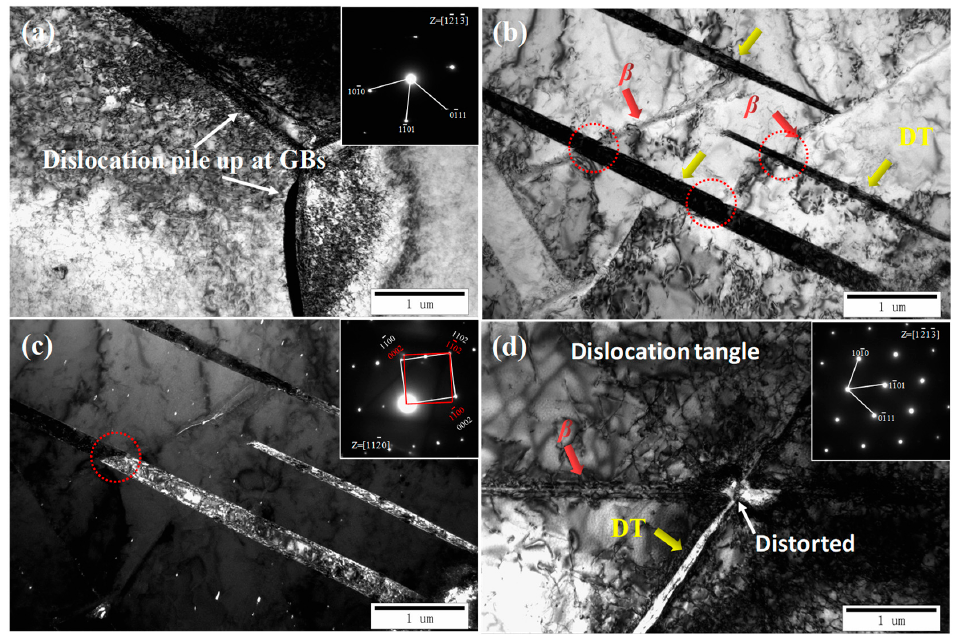
Figure 6. TEM images of the different TA3 samples after impact deformation, about 2 mm away from the impact fracture surface. ( a ) FG Ti, ( b , c ) MG Ti, ( d ) CG Ti, and the inset images are the corresponding select electron diffraction patterns.